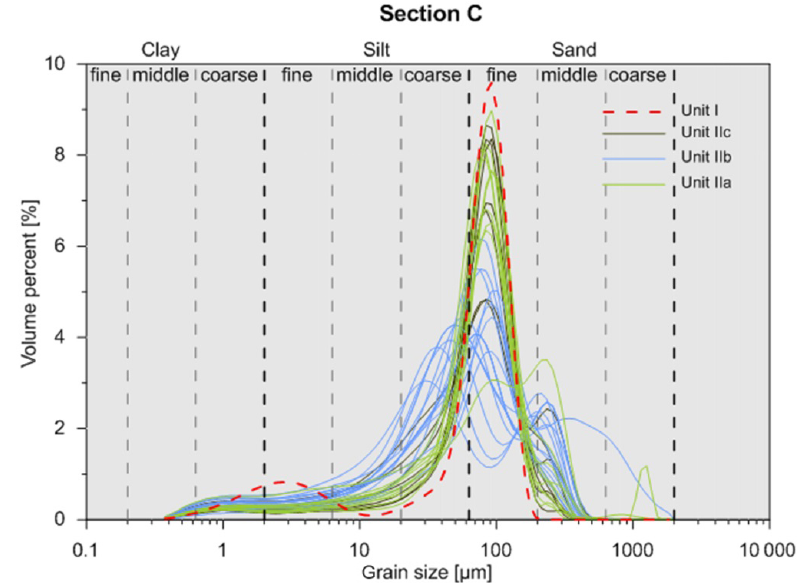
Figure 12. Grain size distribution plot for section C of the Batagay